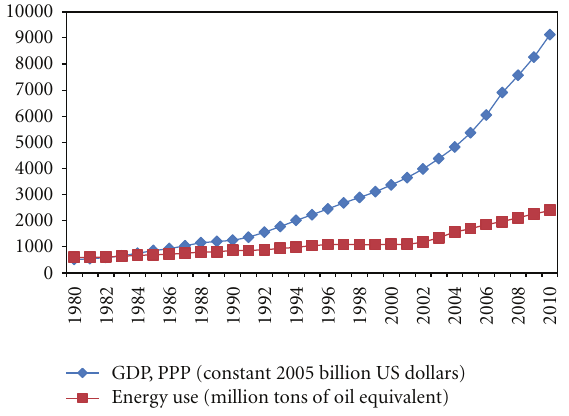
Figure 1: China’s energy use and GDP from 1980 to